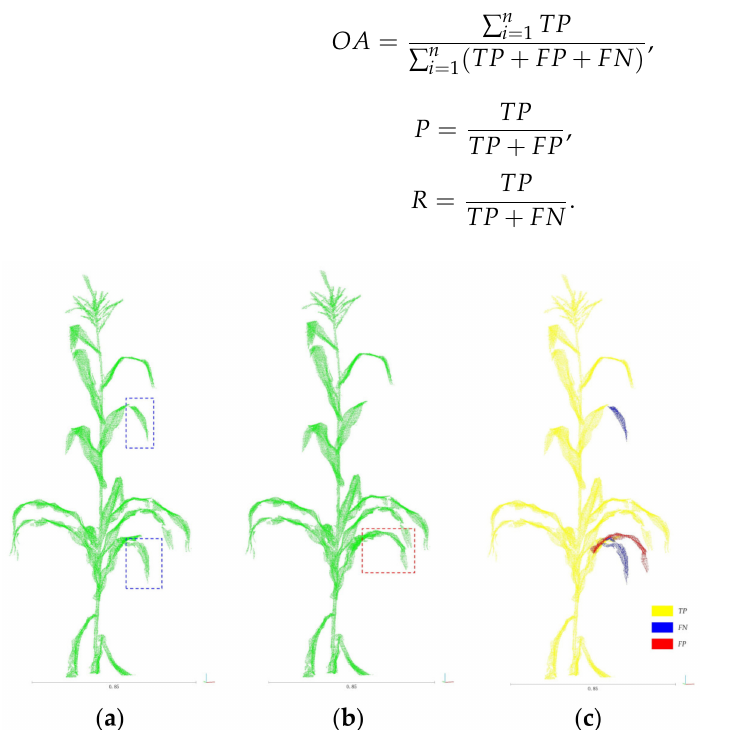
Figure 8. Determination method of TP , FN , and FP of single maize segmentation. ( a ) Standard value of individual plant segmentation, the blue boxes mark the location of FN ; ( b ) Segmentation model output value, the red box marks the location of FP ; ( c ) Decisions of TP , FN , and FP . TP renders as yellow point clouds, FN renders as blue point clouds, and FP renders as red point